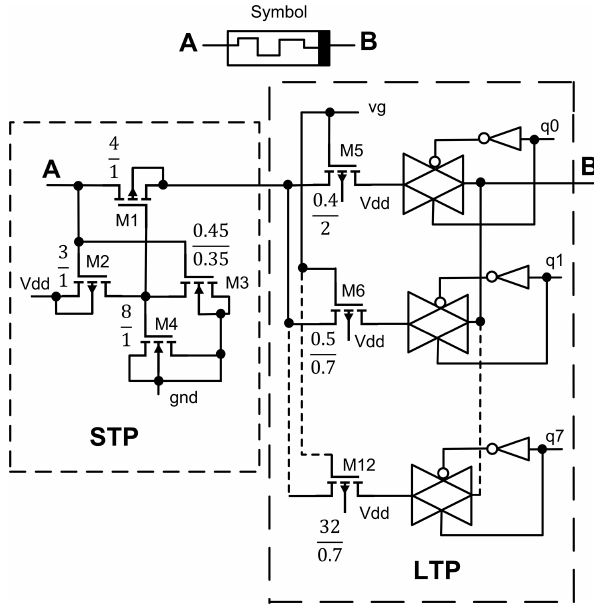
Figure 2. CMOS memristor mimics the synaptic plasticity, long- term plasticity (LTP), and short-term plasticity (STP) of biological synapses. This circuit represents the adaptive synapse (AS) of our proposed structure (sizes of the transistors are in